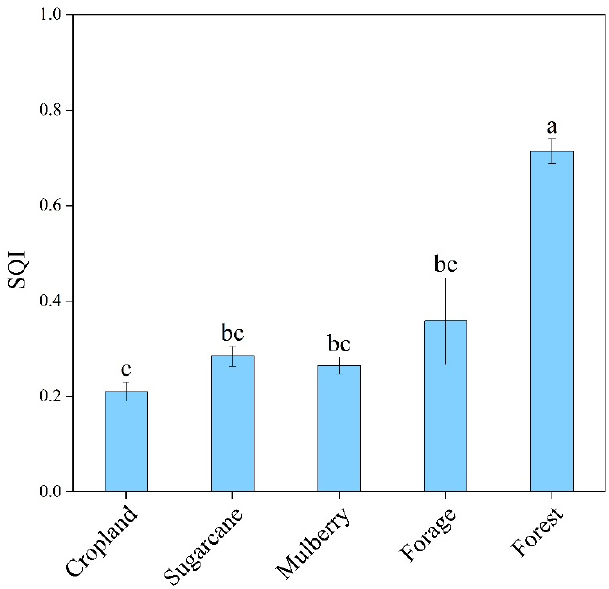
Figure 4. Effects of land-use type on the SQI. Values are means ± SE. Means with the same letter are not significantly different ( p > 0.05) according to the LSD test.